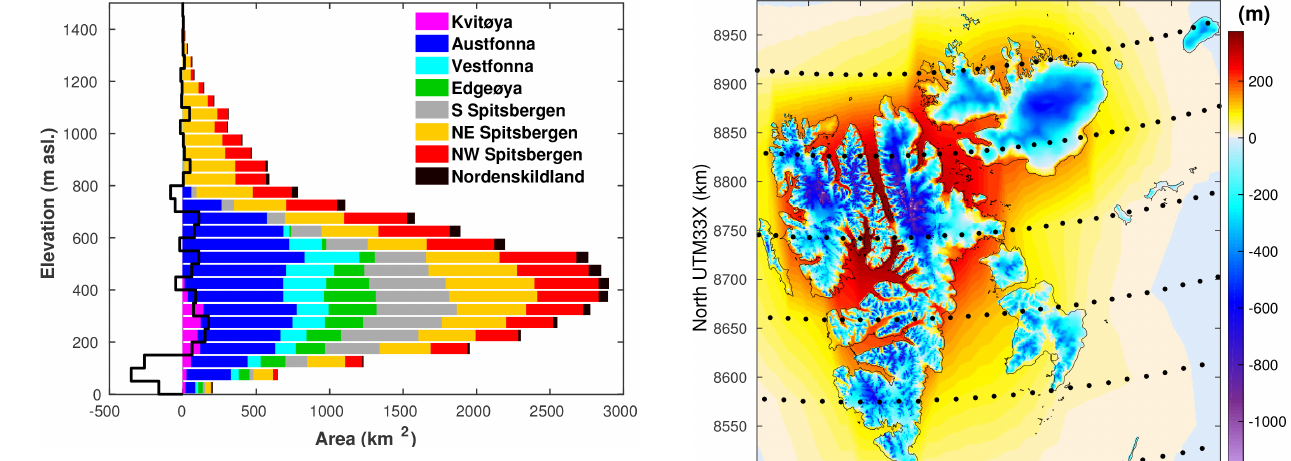
Figure 2. Regional glacier hypsometry of the 2000s inventory. Stacked bars correspond to the entire Svalbard glacier area. Altitude intervals of 50m. The black line is the difference between hypsom- etry of the 90m DEM and the applied 1km DEM, for the whole of Svalbard.